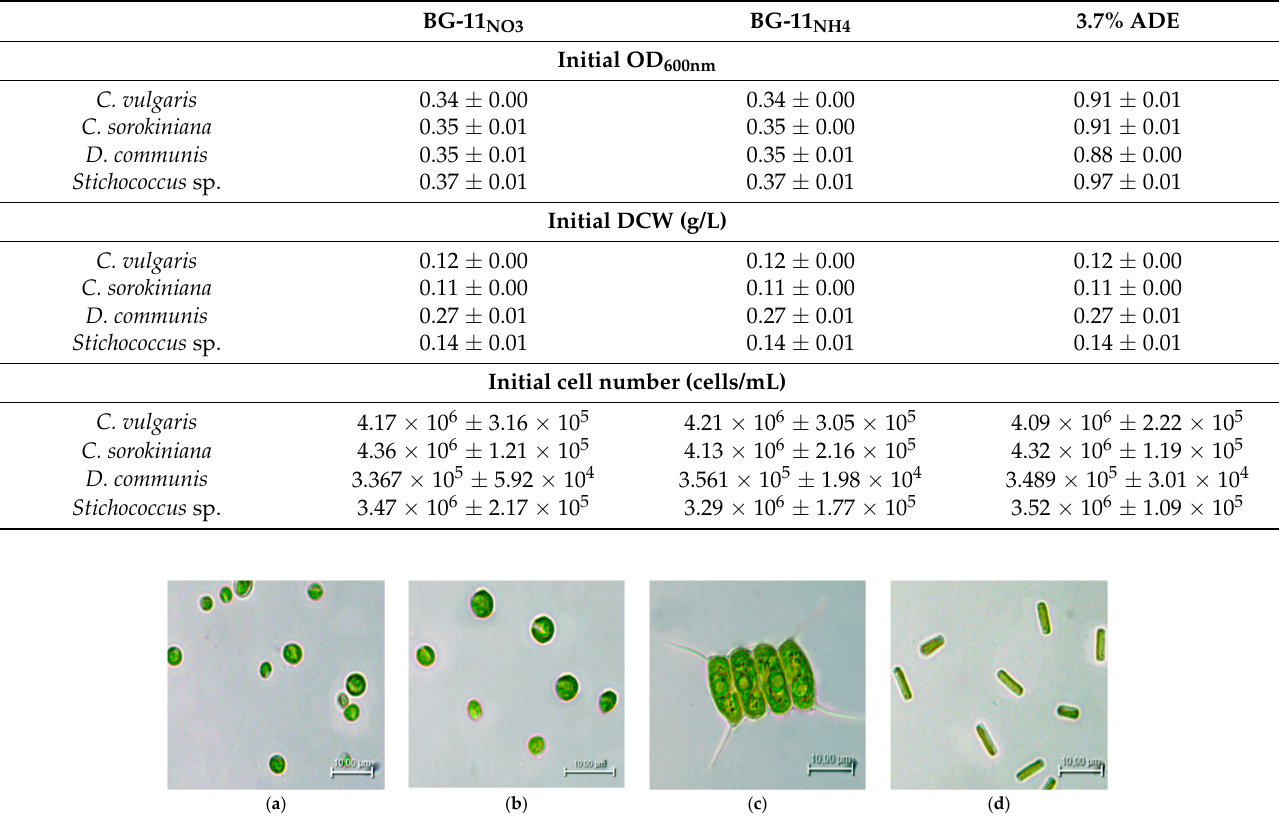
Figure 1. Microalgae species used in the present study: ( a ) C. vulgaris , ( b ) C. sorokiniana, ( c ) D. communis and ( d ) Stichococcus sp.